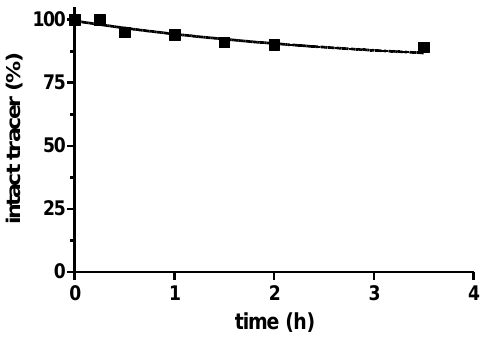
Figure S1. Radiochemical purity of [ 177 Lu] NT127 after incubation in human serum in vitro at 37 °C for up to 3.5 h as determined by radio-HPLC.